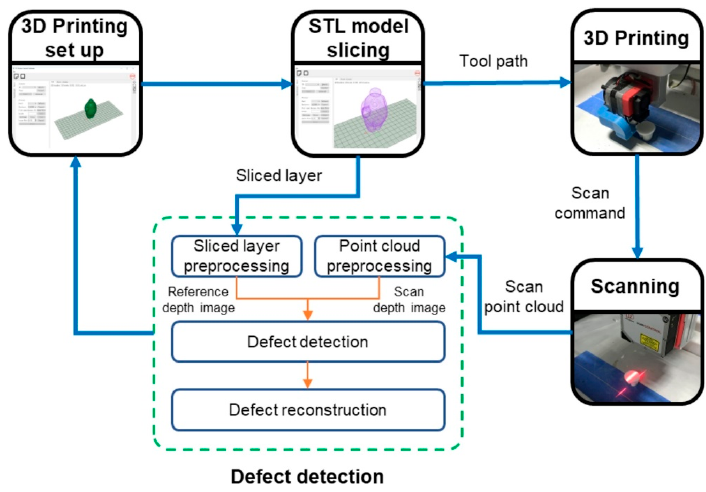
Figure 15. The 3D scanning technology used in inspection [85].